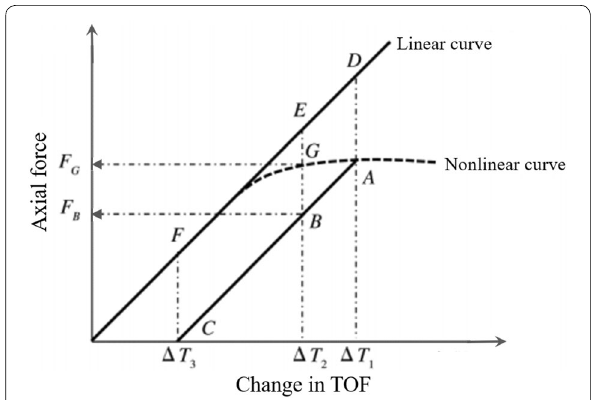
Figure 19 Property curve of bolts